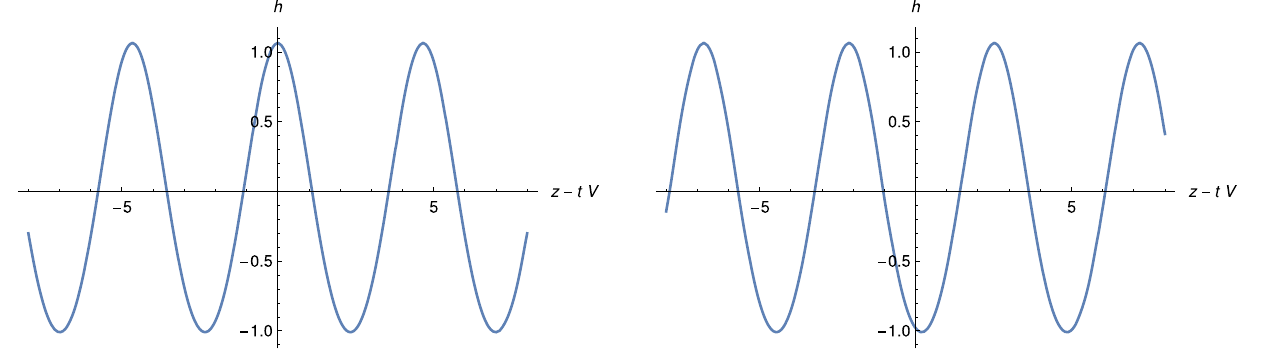
Fig. 3 Plot of the solution (5.25) corresponding to the three real root case. The parameters have the following values: Y = ω 0 = g = 1, λ = V = 0 . 5, χ = 2, κ = 3, z = 0